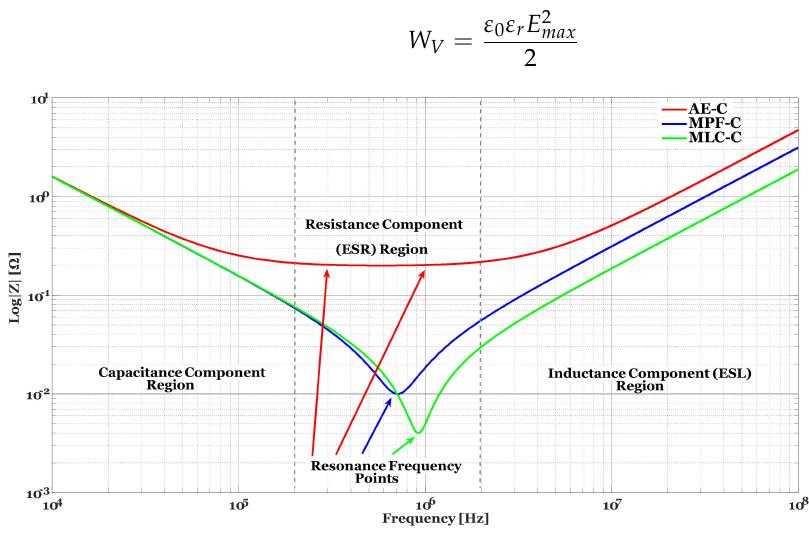
Figure 5. Frequency response of various types of 1 µ F 450V capacitors.